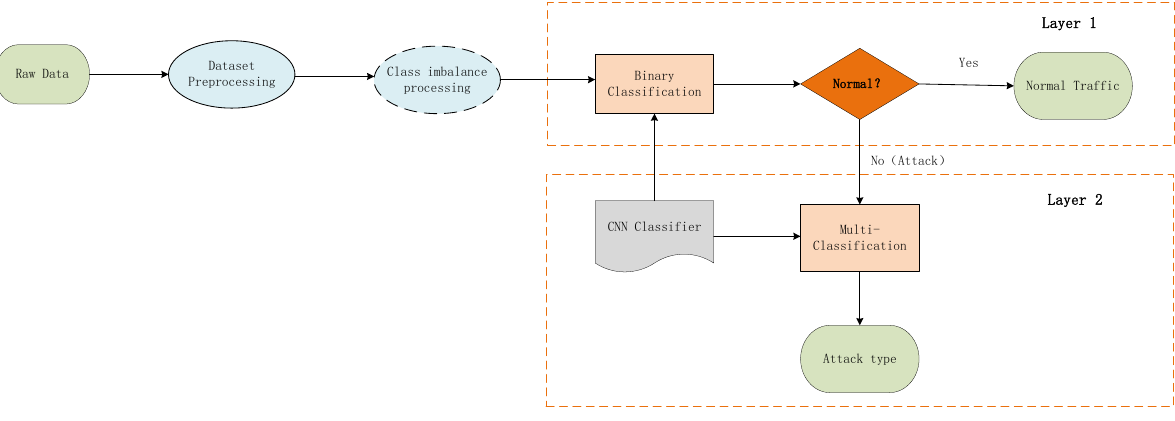
Figure 1. CSK-CNN intrusion detection model.